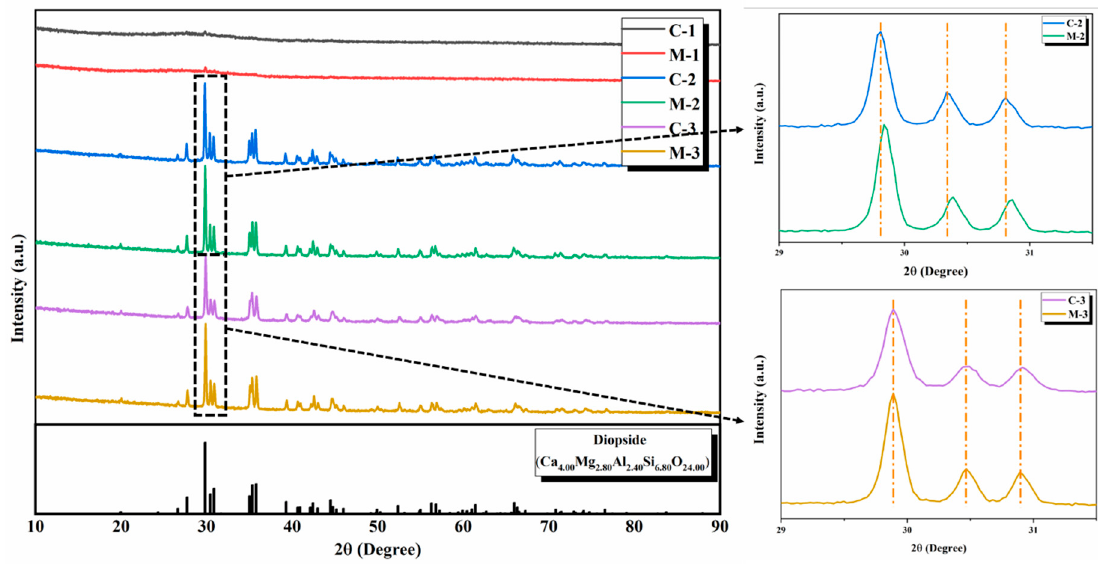
Figure 2. X-ray di ff raction (XRD) pattern of crystallized glass-ceramics by conventional and Figure 2. X-ray diffraction (XRD) pattern of crystallized glass-ceramics by conventional and microwave microwave heating.